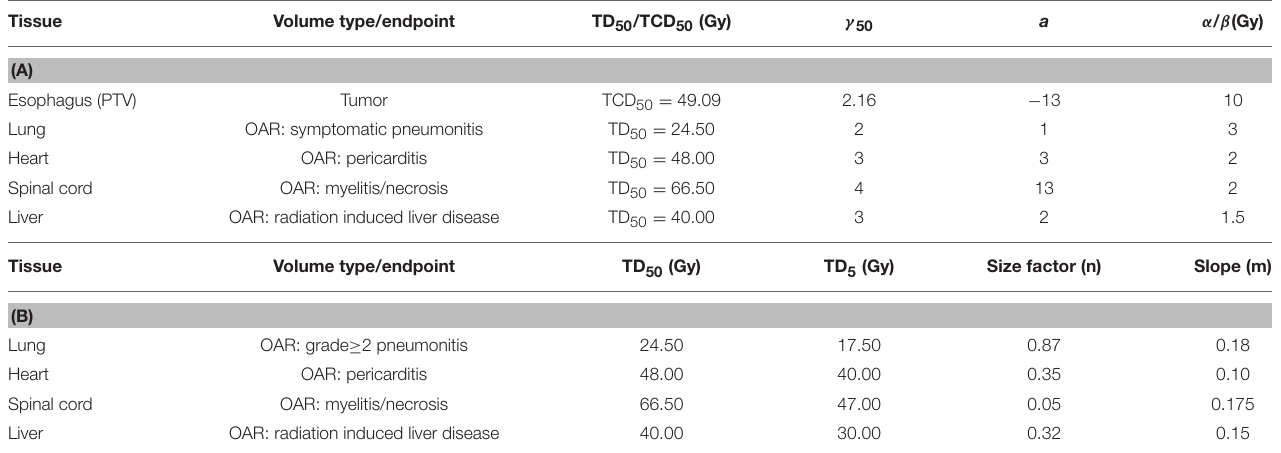
TABLE 2 | Radiobiological parameters used to calculate TCP and NTCP by Niemierko’s model (A) or LKB model (B) .